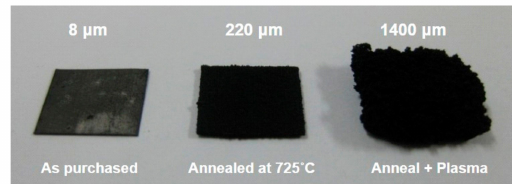
Figure 7. Digital image showing the e ff ect of substrate pretreatment on CNT